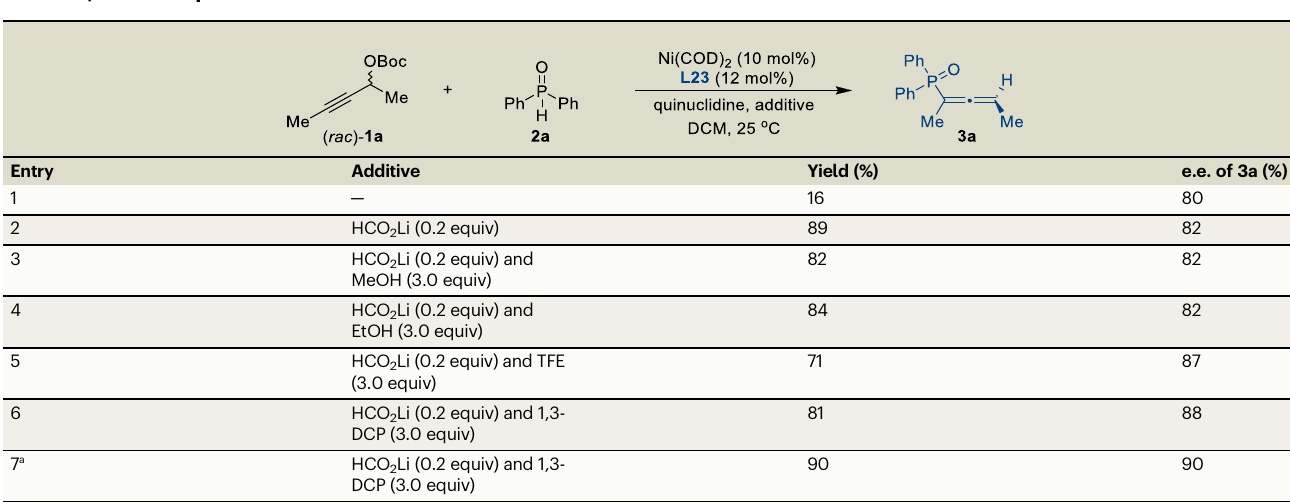
Table 2 | Further